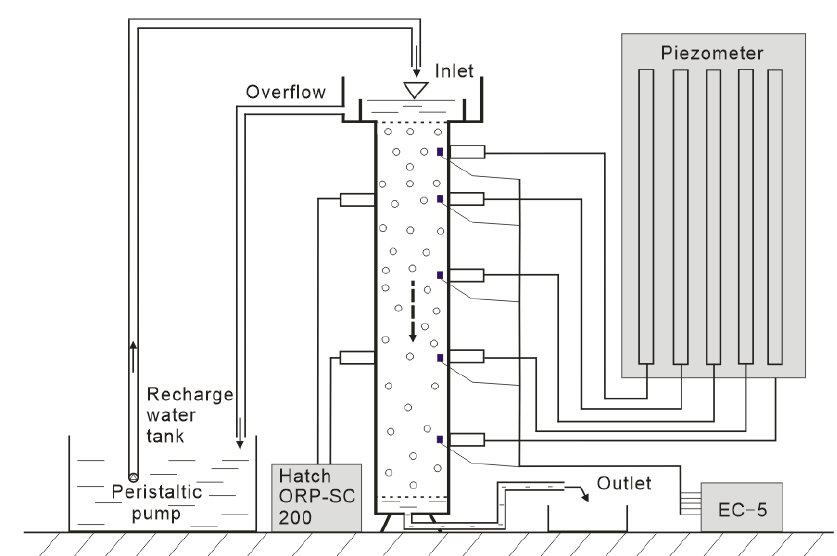
Figure 1. Physical diagram of the intermittent recharge experimental setups. The whole experiment process consisted of three recharge stages separated by two intermittences. The water was pumped from the tank into the water supply controller of the sand column, and the water above the specified level flowed back to the recharge water tank through the overflow port. The recharge water flowed through the sand column from top to bottom and flowed out from the specified elevation downstream outlet, which was set above the bottom of the sand column to maintain a threshold saturated zone during recharge intermittence. All the columns were flushed with about 3 pore volumes of background tap water before experiment. The first recharge process was started